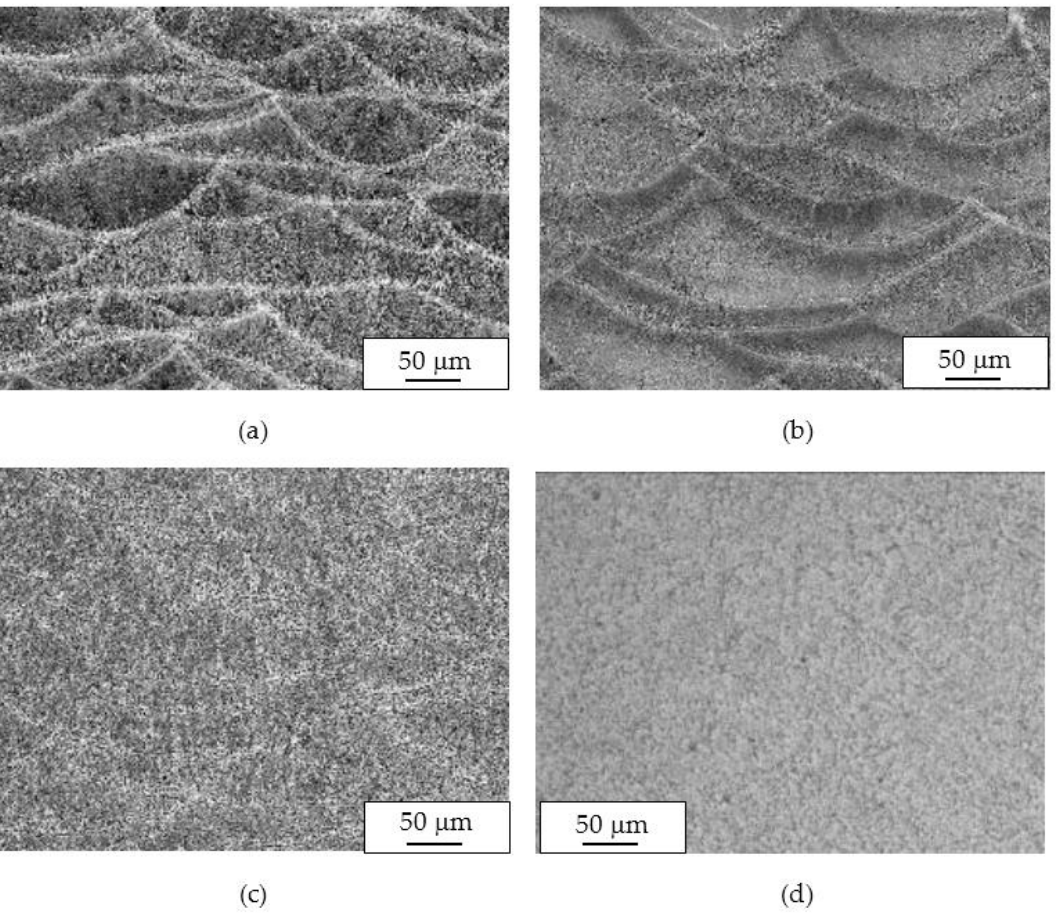
Figure 5. Macrostructure of XZ plane specimens after 2 h of heat treatment at different temperature: ( a ) 200 °C; ( b ) 300 °C; ( c ) 400 °C; and ( d ) 500 °C. ( a ) 200 ◦ C; ( b ) 300 ◦ C; ( c ) 400 ◦ C; and ( d ) 500 ◦